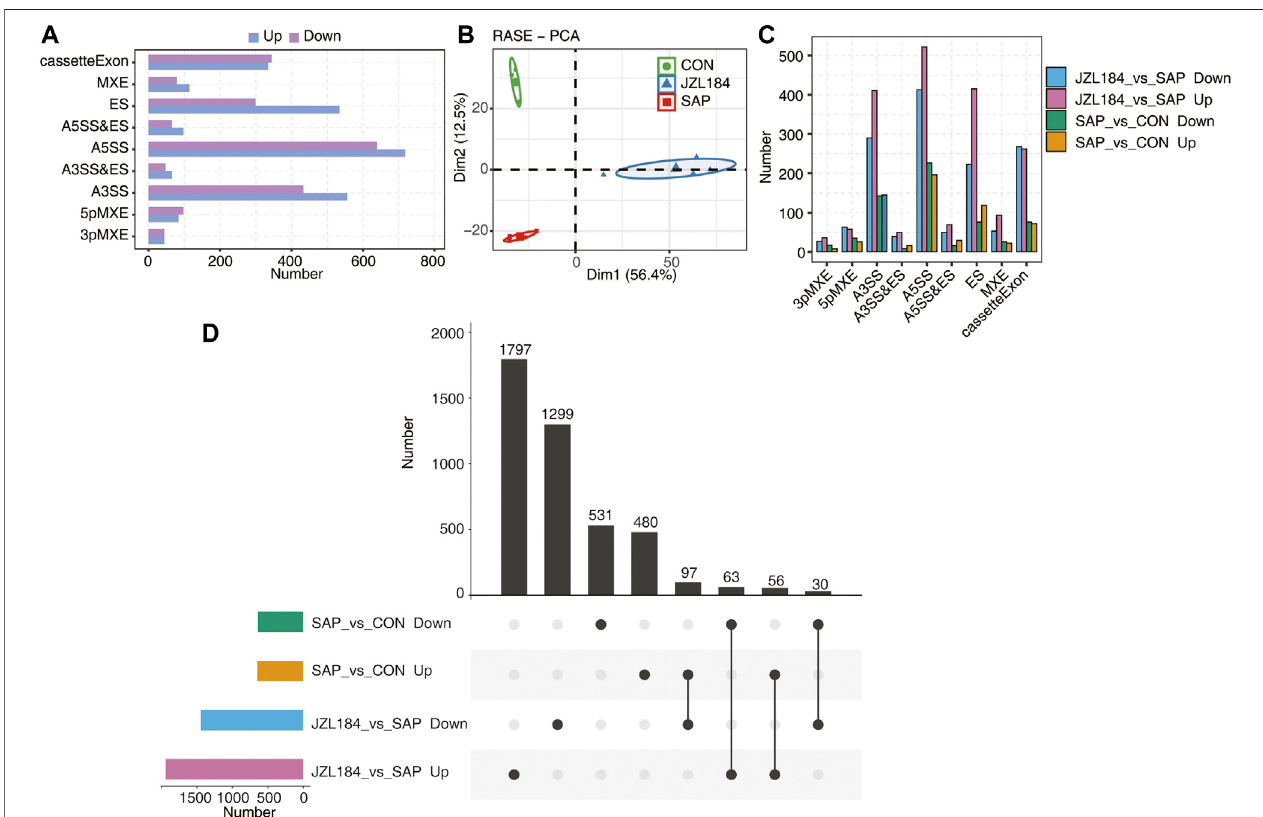
FIGURE 4 | MAGL inhibitor extensively change alternative splicing pattern of genes in intestinal tissue of rats with SAP. (A) Bar plot showing the MAGL regulated alternative splicing event (RASE) numbers by classifying them into nine type. (B) PCA base on Ratio value of the MAGL regulated alternative splicing event (RASE). The ellipse for each group is the con fi dence ellipse. The results showed that the con fi dence ellipsis of the three groups did not overlap and the samples were obviously discriminated; (C) Bar plot showing the MAGL regulated alternative splicing event (RASE) numbers in the four comparison groups. 480 ASEs were speci fi cally upregulated in the SAP group compared with the control group, 1797 ASEs were speci fi cally upregulated in the JZL184 group compared with the SAP group, 1,299 ASEs were speci fi cally downregulated in the JZL184 group compared with the SAP group, and 531 ASEs were speci fi cally downregulated in the SAP group compared with the control group; (D) Overlap analysis plots of RASE in each group. 97 ASEs were downregulated in the JZL184 group compared with the SAP group, but were upregulated in the SAP group compared with the control group; n = 3 in control group. n = 4 in SAP group and JZL184